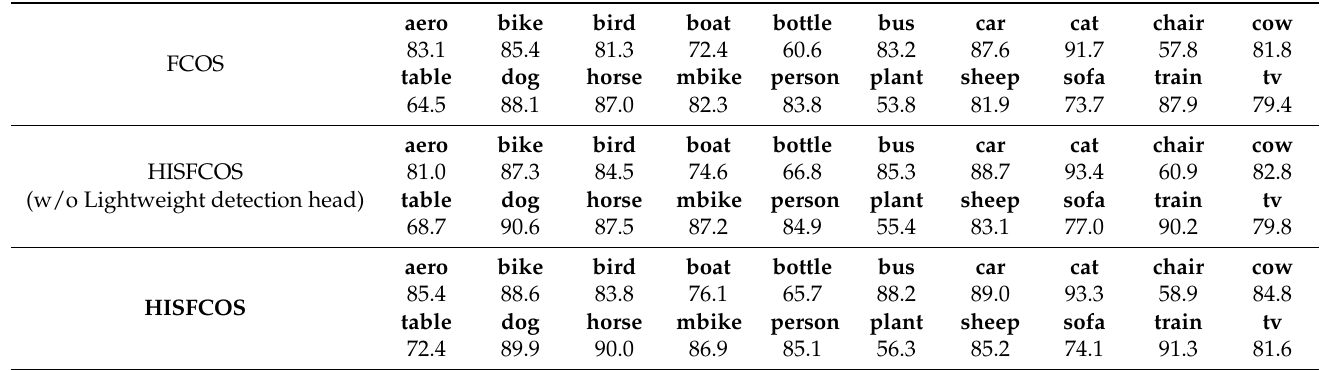
Table 4. Ablation study for HISFCOS analysis on PASCAL VOC 2007 test dataset.